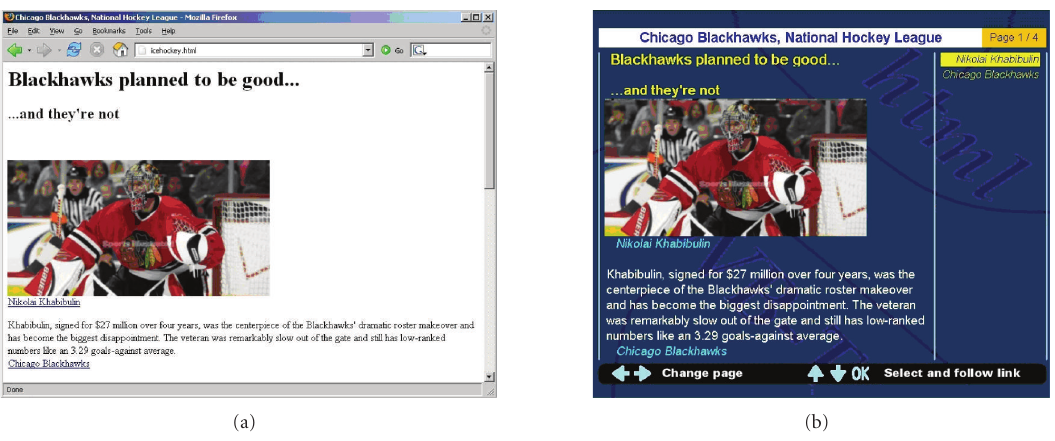
Figure 10: Web page visualization on the Web (leftmost screenshot) and on a TV set (rightmost